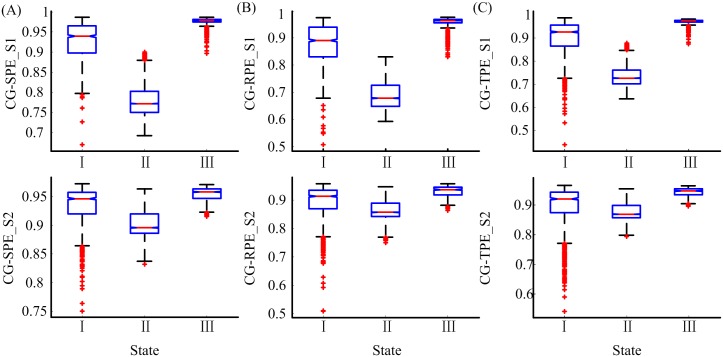
The statistical box plots of CG-SPE, CG-RPE and CG-TPE at scale 1 and 2 in awake state (I), unconsciousness (II) and RoC state (III).S1, S2 represent scale 1 and 2, respectively.